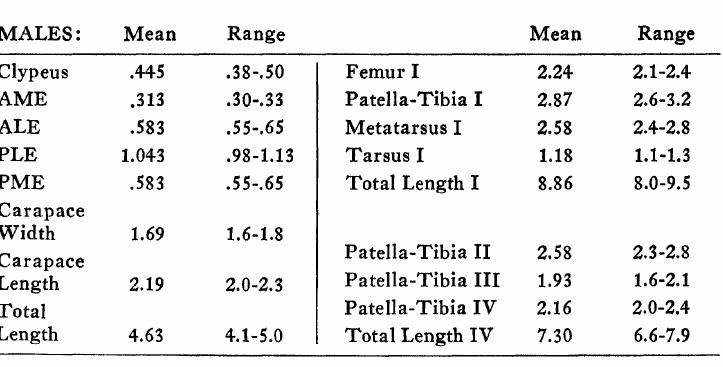
Color. Female. Face and chelicerae pale yellow to light yello.w- orange with dark stripes rom AME to subdistal region of chelicerae as in Figure 5. Eyes with black nacelles, overlaid with white spatu- late